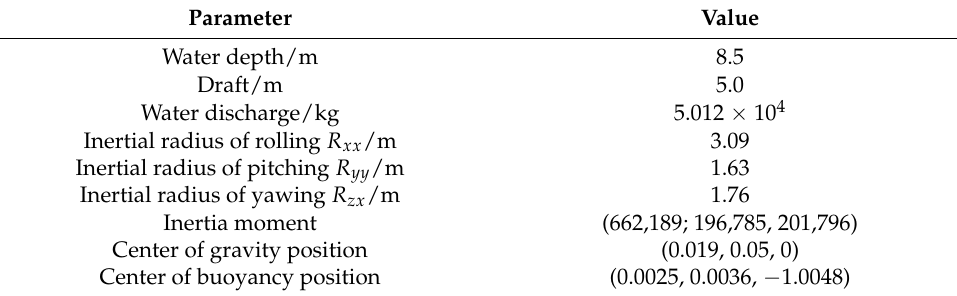
Table 2. Hydrodynamic parameters of breakwater.